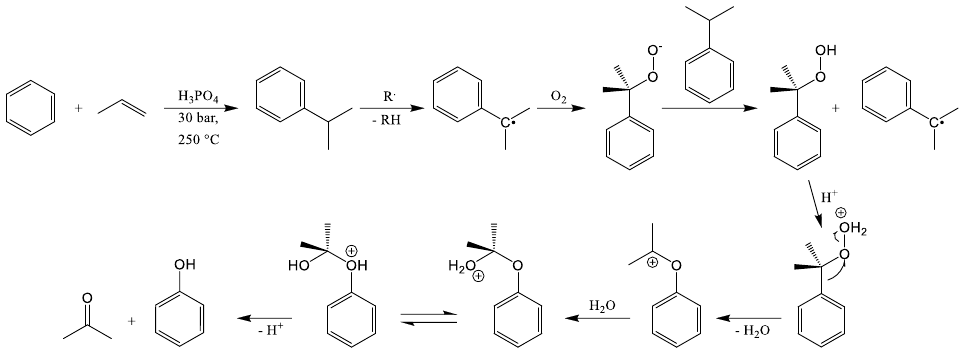
Figure 2. Scheme of the general mechanism of the cumene process [14].